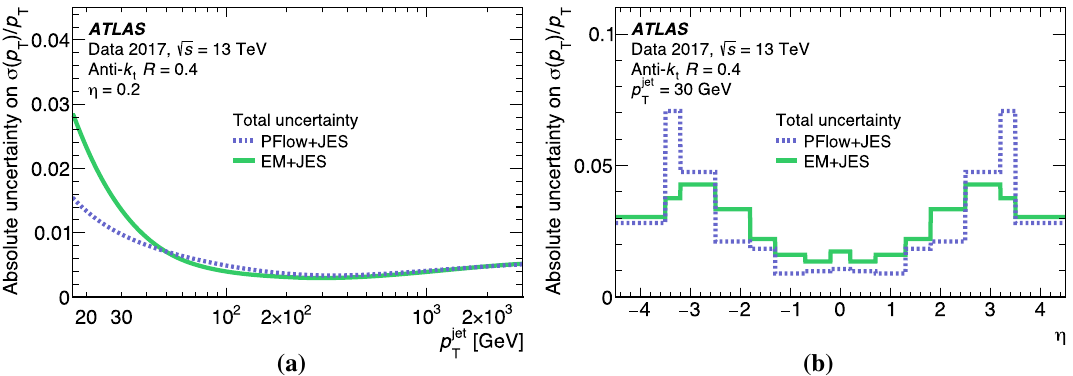
Fig. 30 The relative jet energy resolution for fully calibrated PFlow+JES jets (blue curve) and EM+JES jets (green curve) a as a function of p jet and b as a function of η . The fit to the resolution as a function of p jet jets at low- p T